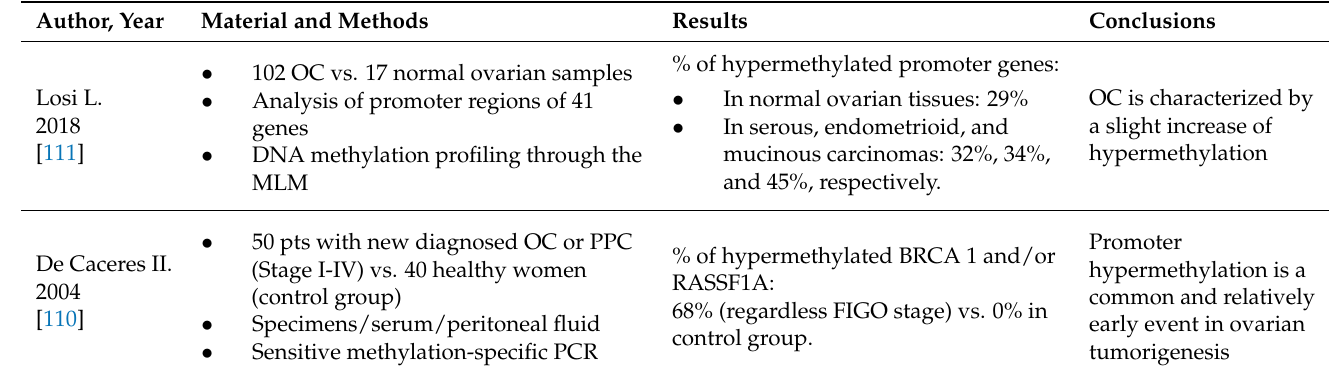
Table 5. Most relevant evidence about the value of methylation alteration in